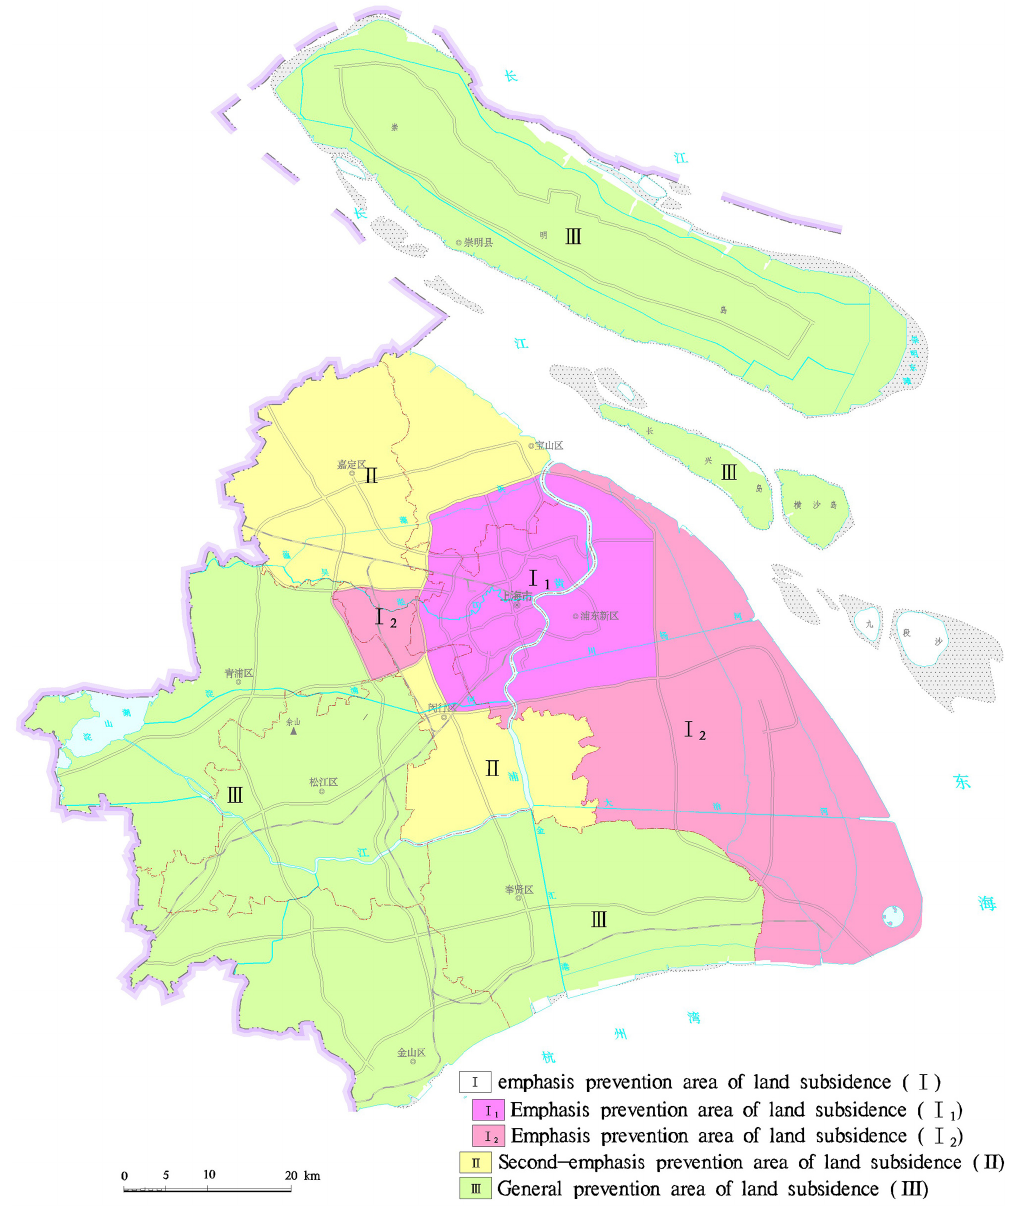
Figure 4. Land subsidence regional prevention and control